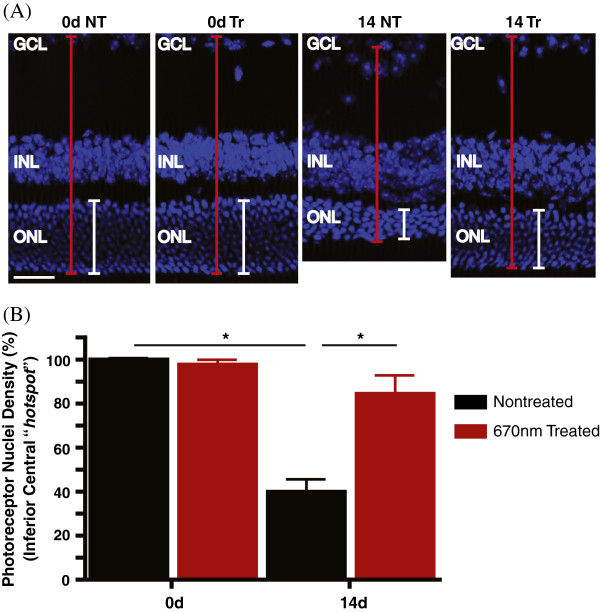
Effects of 670 nm light treatment on the population of photoreceptors hyperoxic mice. (A) Representative micrographs of retinal sections showing the nuclear layers stained with Bisbenzimide (blue). To account for obliquely cut retina and possible artefacts, the ratio of the ONL (white line) to the OLM-ILM (red line) was used for analyses. (B) Quantitative analysis of photoreceptor nuclei density in the inferior central region of NT group (black bar) and Tr mice (red bar). Compared with the nontreated retinas at 14d hyperoxia (14dNT), treatment with 670 nm red light induced a significant level of photoreceptor nuclei density preservation in the 14dTr group (*p < 0.001). Scale bar 50 μm in A.